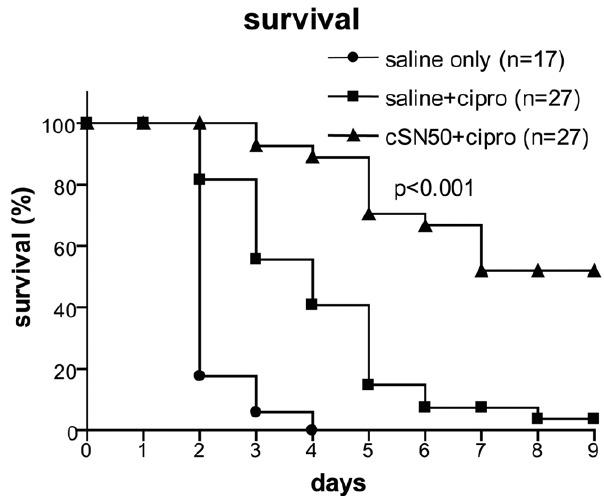
Figure 1. Survival in inhalational anthrax was increased by combination of cSN50 with ciprofloxacin. Female A/J mice were infected intranasally (IN) with 10 7 B. anthracis spores and treated with 15 injections of cSN50 during the first 2 days and daily ciprofloxacin (triangles) or saline and ciprofloxacin (squares) or saline without ciprofloxacin (circles). The p value represents the significance of the difference in survival between the two ciprofloxacin-treated groups (with and without cSN50